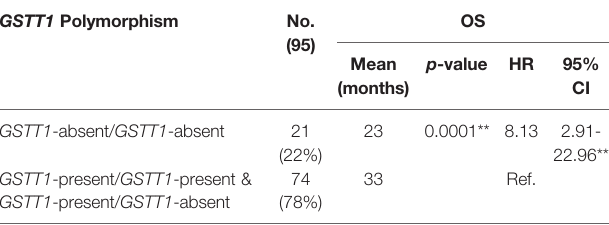
TABLE 4 | Associations between GSTT1 genotypes and overall survival